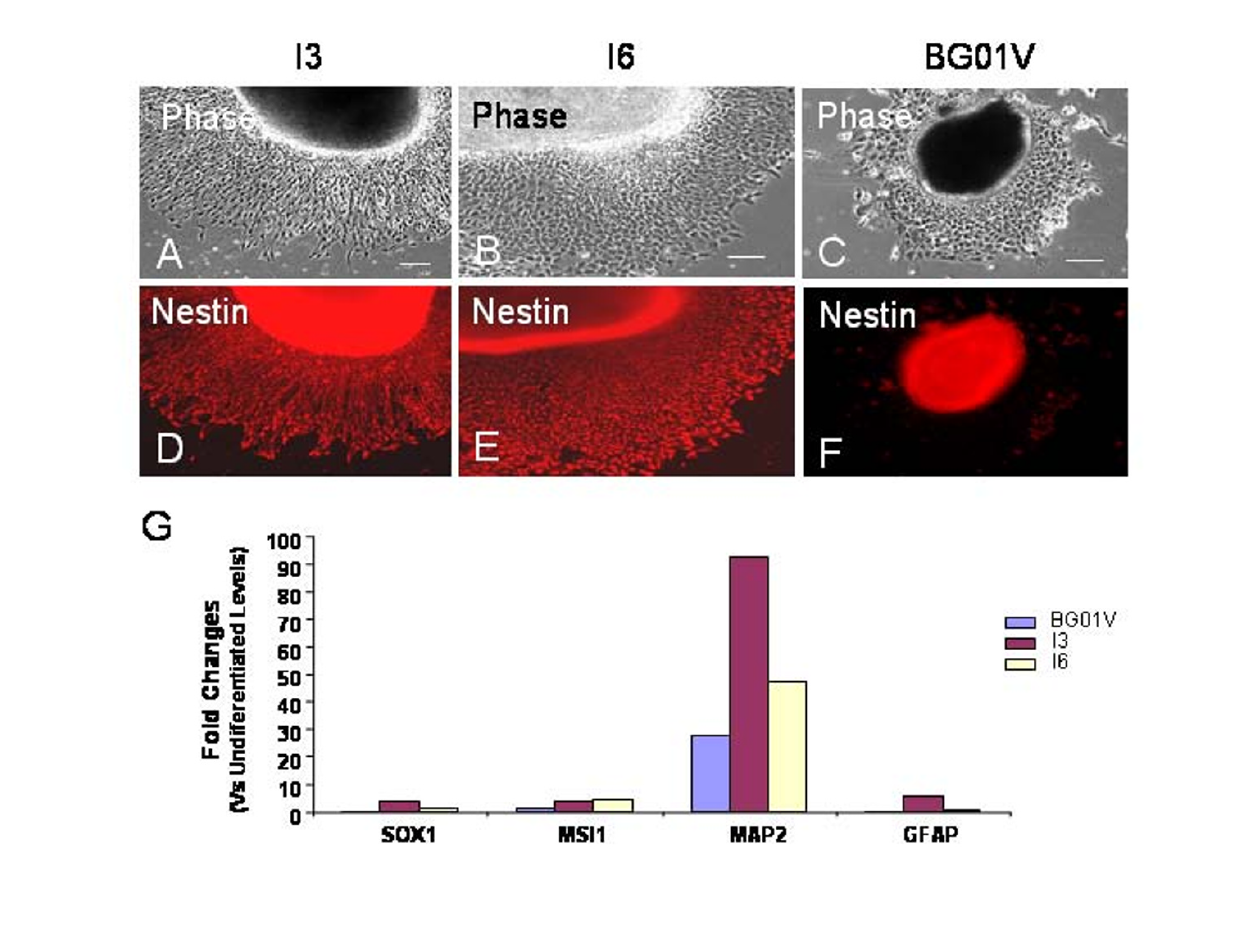
Figure 9 Difference in directed neural differentiation between hESC lines I3, I6 and BG01V . Two days after transferring EBs to a poly-D-lysine/laminin substrate, parallel immunocytochemistry and quantitative RT-PCR were performed in hESC-derived cell populations. Immunofluorescent staining for Nestin (A-F) shows that both the I3 and the I6 cells differentiate into the enriched Nestin + neural progenitors while BG01V cells barely generate Nestin + cells. Bars in A-C = 100 μ m. (G) qRT-PCR analysis of the gene expression of the neural progenitor markers SOX1 and MSI1, mature neuronal marker MAP2, and astro- cyte marker GFAP among the three cell lines at day 17 of differentiation. The Y-axis represents the fold changes of the gene expression for each cell line when compared to its own undifferentiated levels at day 0. The relative levels of these genes expressed by the I3 and I6 cells are higher than those expressed by BG01V